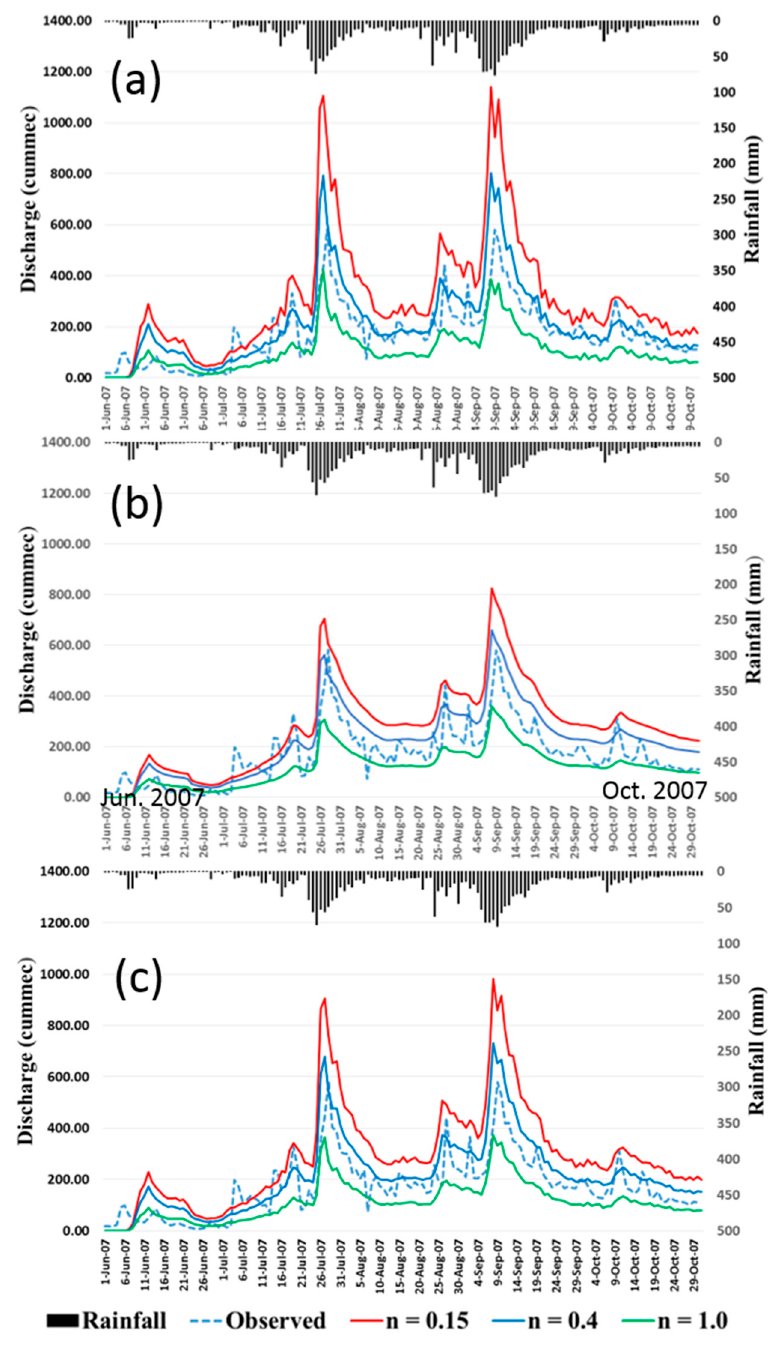
Figure 7. Sensitivity to the Manning’s n values in ( a ) SRTM DEM; ( b ) ASTER DEM; and ( c ) CARTO DEM based on the discharge at the outlet.